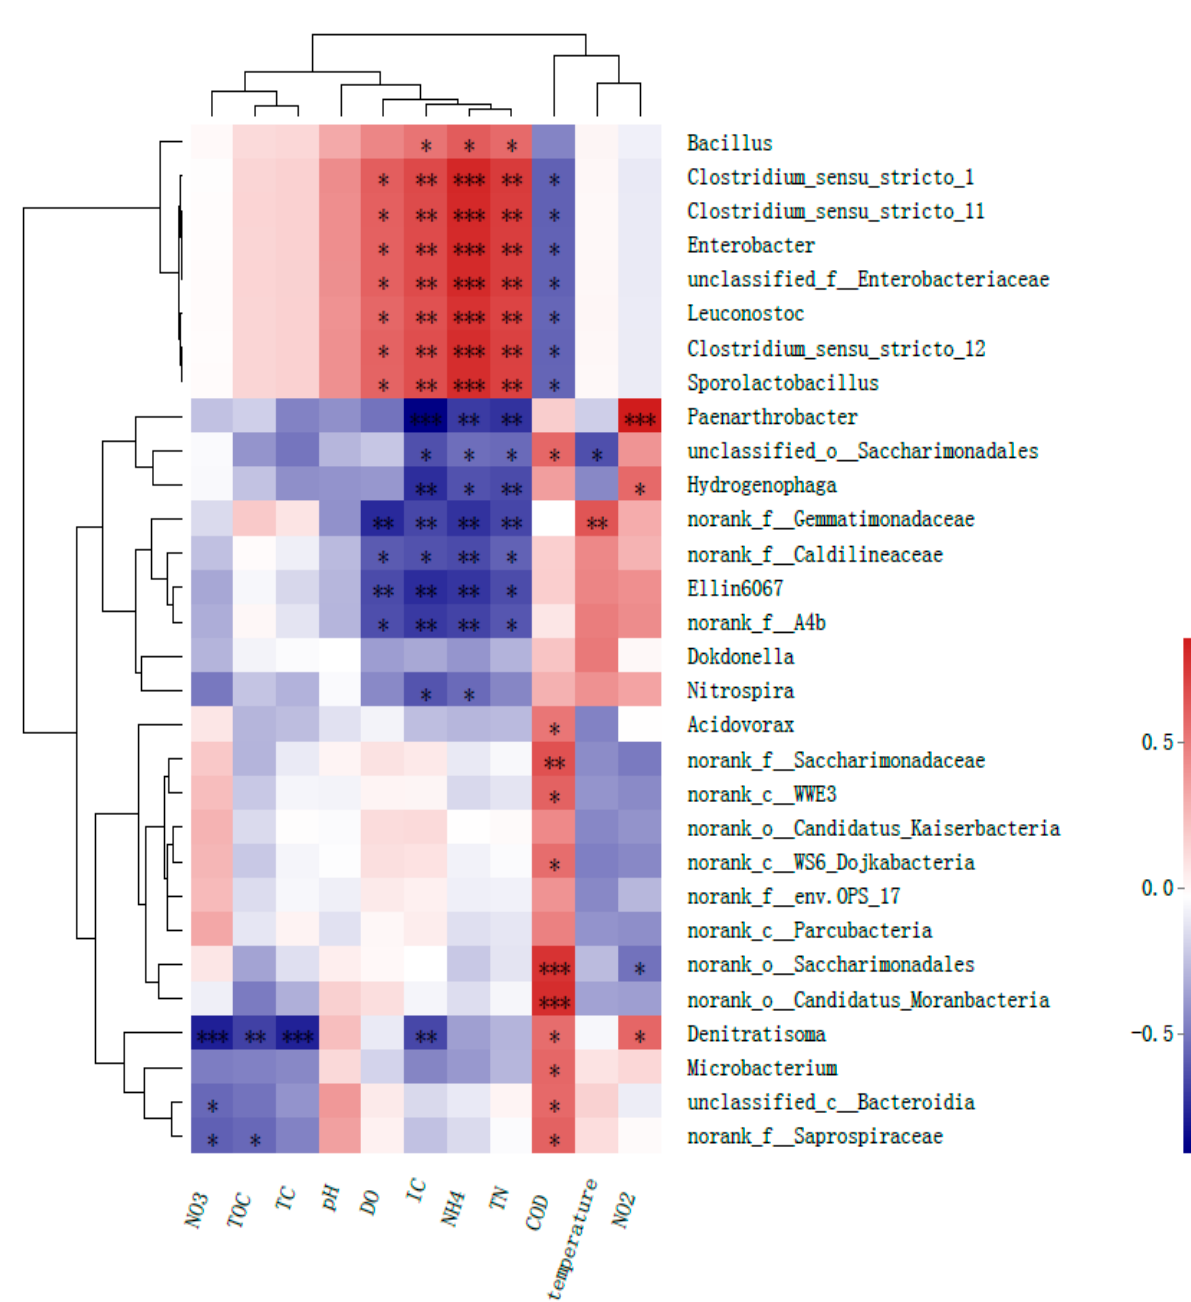
Figure 7. Correlation heatmap analysis. (0.5 < p < 0.1: *; 0.01 < p < 0.5: **; p < 0.01: ***)